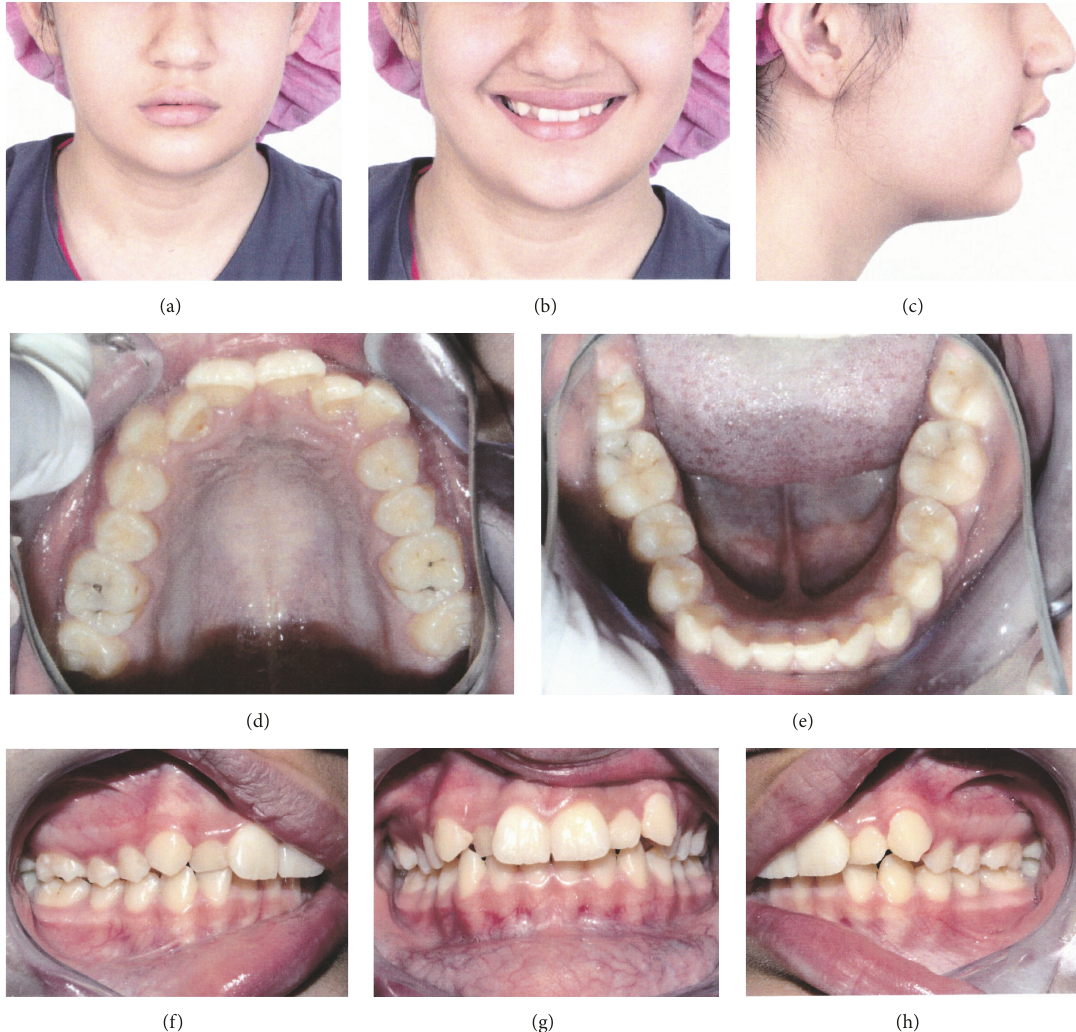
Figure 1: Initial photos: frontal (a); smile frontal (b); profile (c); intraoral views: upper occlusal (d), lower occlusal (e), right (f), frontal (g), and left